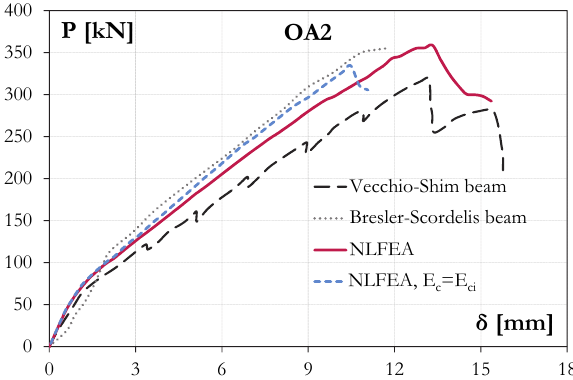
Figure 3: Comparison between experimental [17] and numerical results in terms of applied load vs. midspan deflection for specimen OA2. Numerical analyses have been repeated twice, by differently modeling concrete